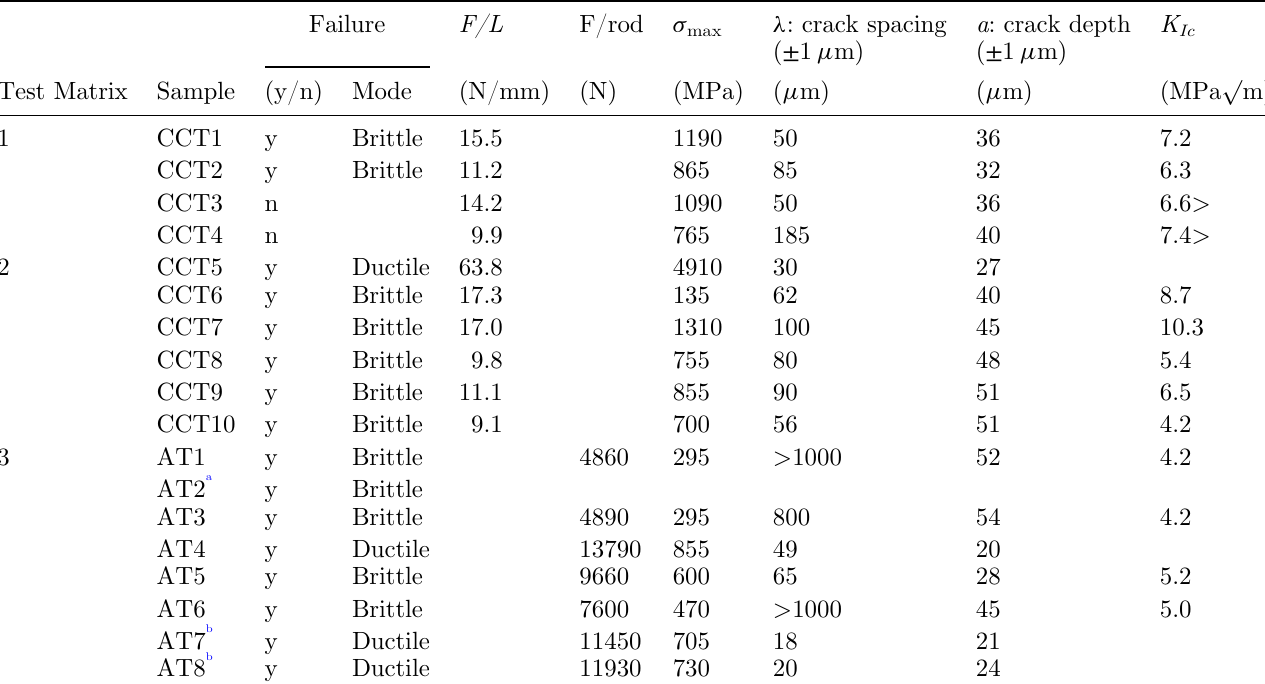
Table 3. Mechanical test results and determination of the sample fracture toughness.